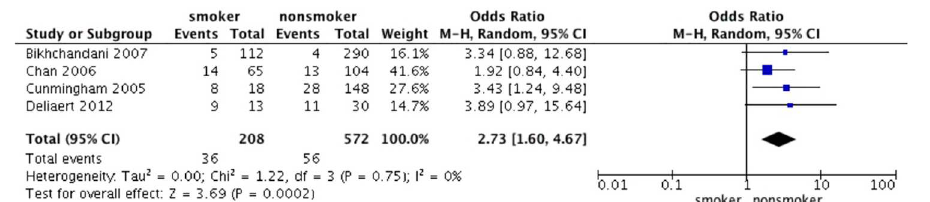
Fig 7. Correlations between smoking and wound dehiscence.